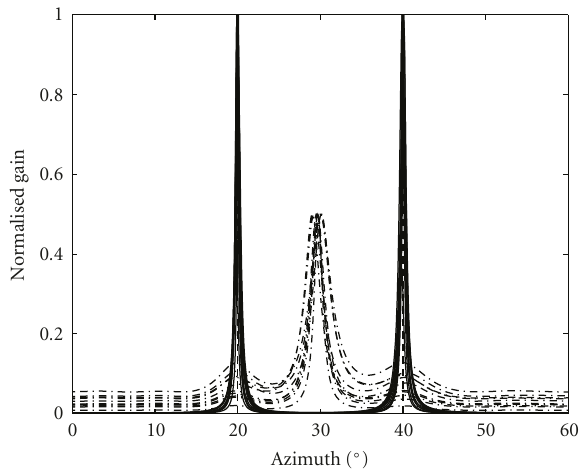
Figure 1: Spatial spectrums of the new method and SC-SSF for two impinging signals with coherent SOCS: - · - for SC-SSF; – for the proposed method.